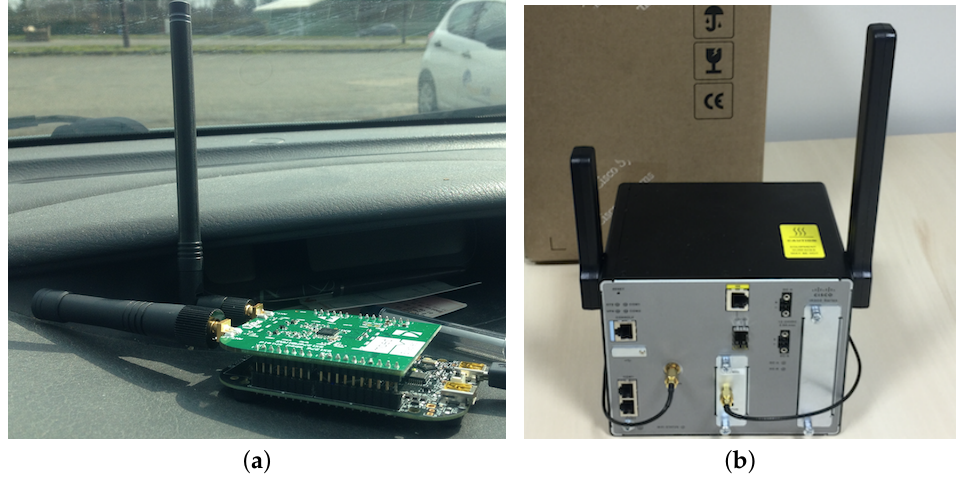
Figure 4. The LoRa testbed. ( a ) The LoRa end-device; ( b ) the LoRa